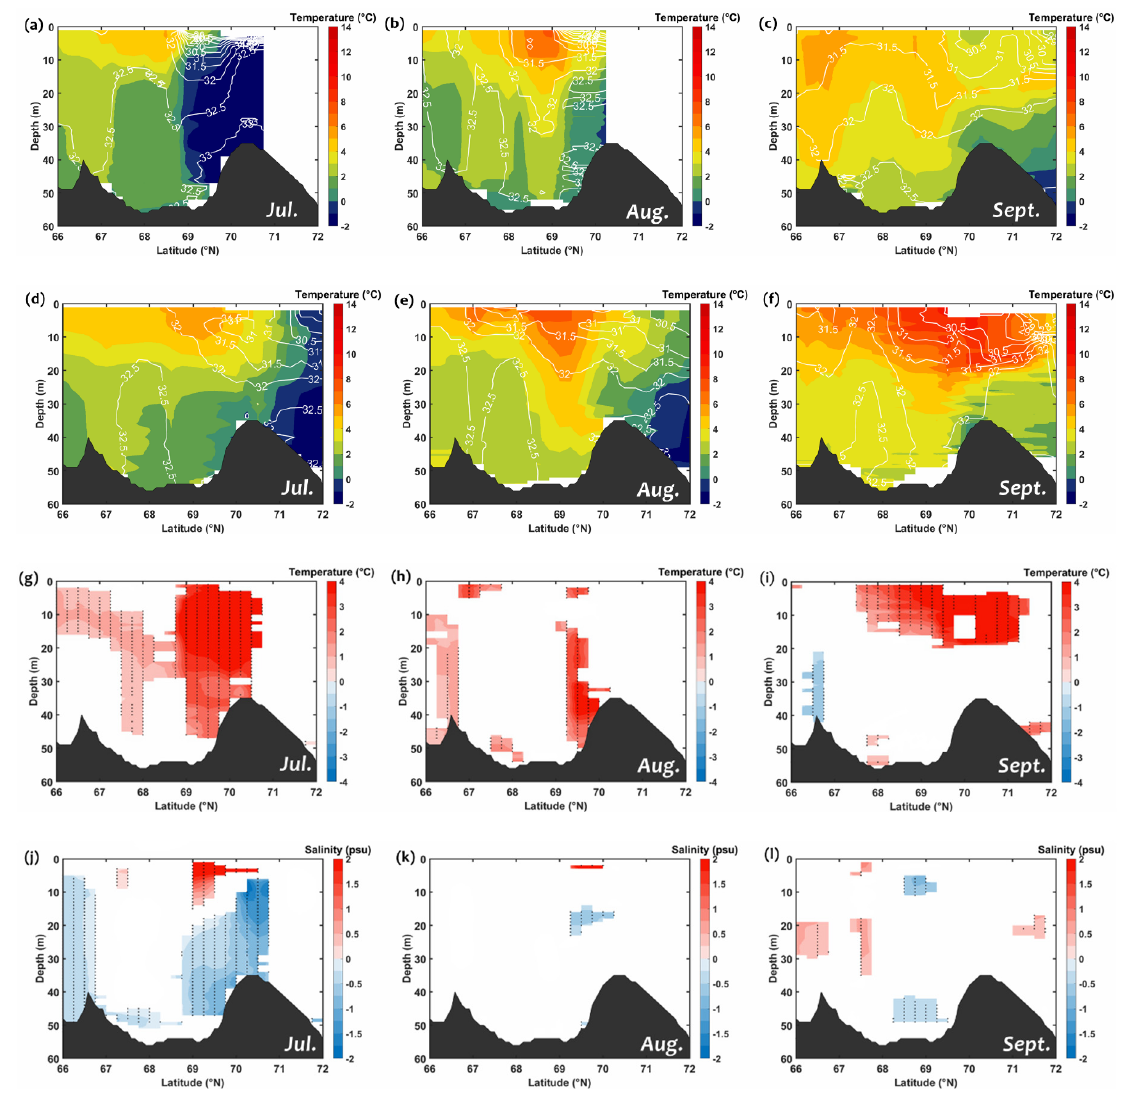
Figure 12. Multi-year mean vertical sections of the temperature (shaded) and salinity (contour) and their differences along 169°W from July to September in ( a–c ) pre- and ( d–f ) post-1997 periods, respectively; Differences in the ( g–i ) temperature and ( j–l ) salinity between the two periods. The color shaded areas and the blank dots in difference maps indicate 95% and 99% confidence level, respectively.